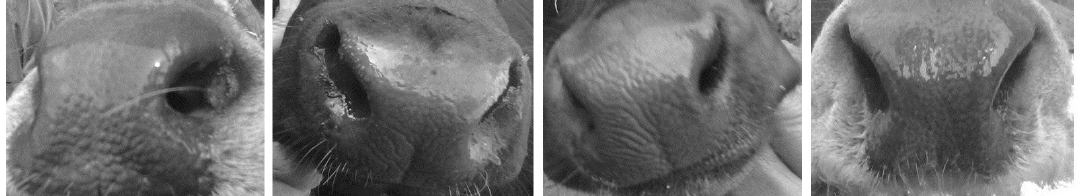
Figure 3. A sample from the nonstandard muzzle prints database of 105 images in total. The sample shows different augmentation parameters, such as image rotation, image blurring and image